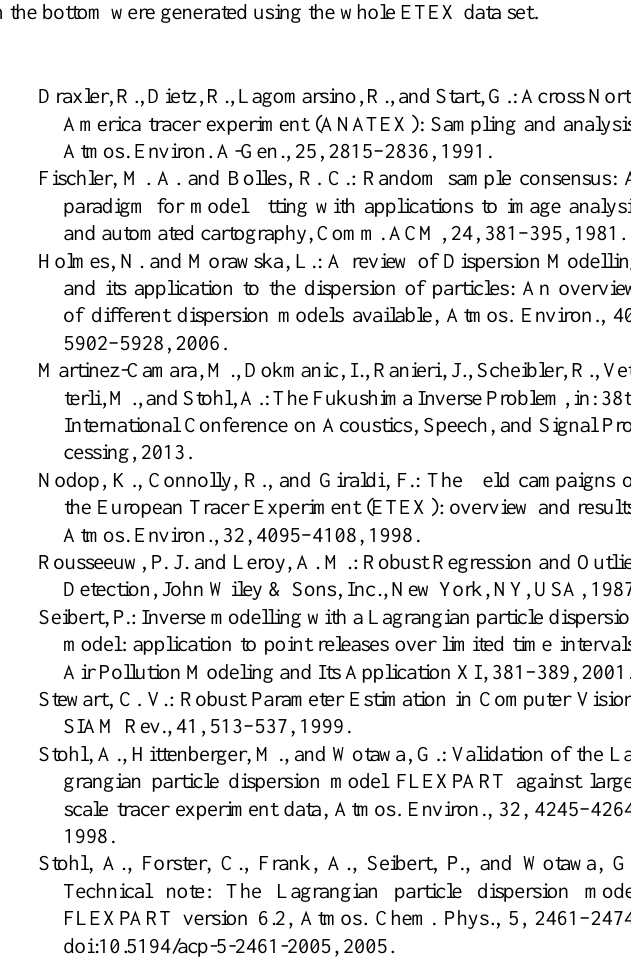
Figure 10. Source reconstructions given by the different algorithms. The plots on the left were generated combining Eq. (2) with RANSAC and TRANSAC. The plots on the right were generated combining Eq. (3) with TRANSAC and RANSAC. The plots on the top were generated using the ETEX data set without critical measurements. The plots on the bottom were generated using the whole ETEX data